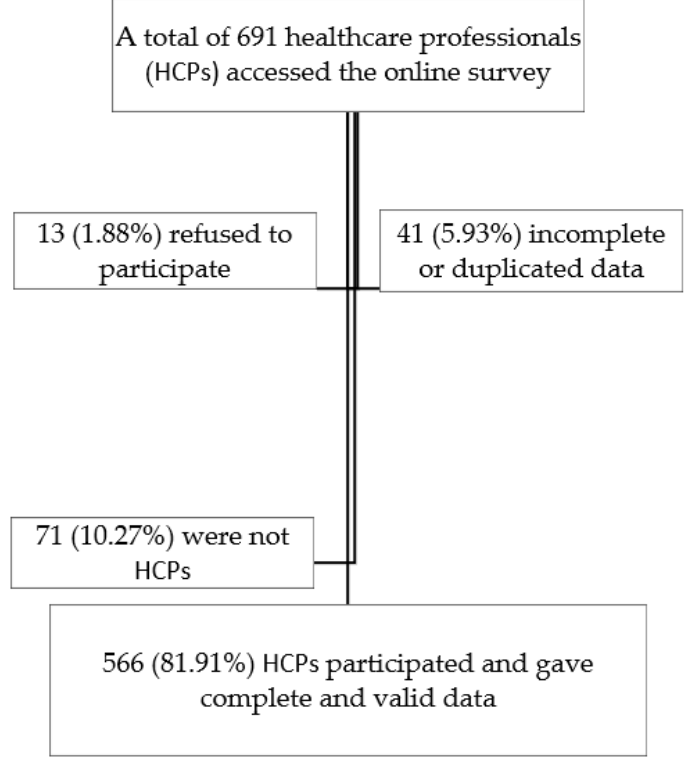
Figure 1. sample flowchart. Figure 1. Sample